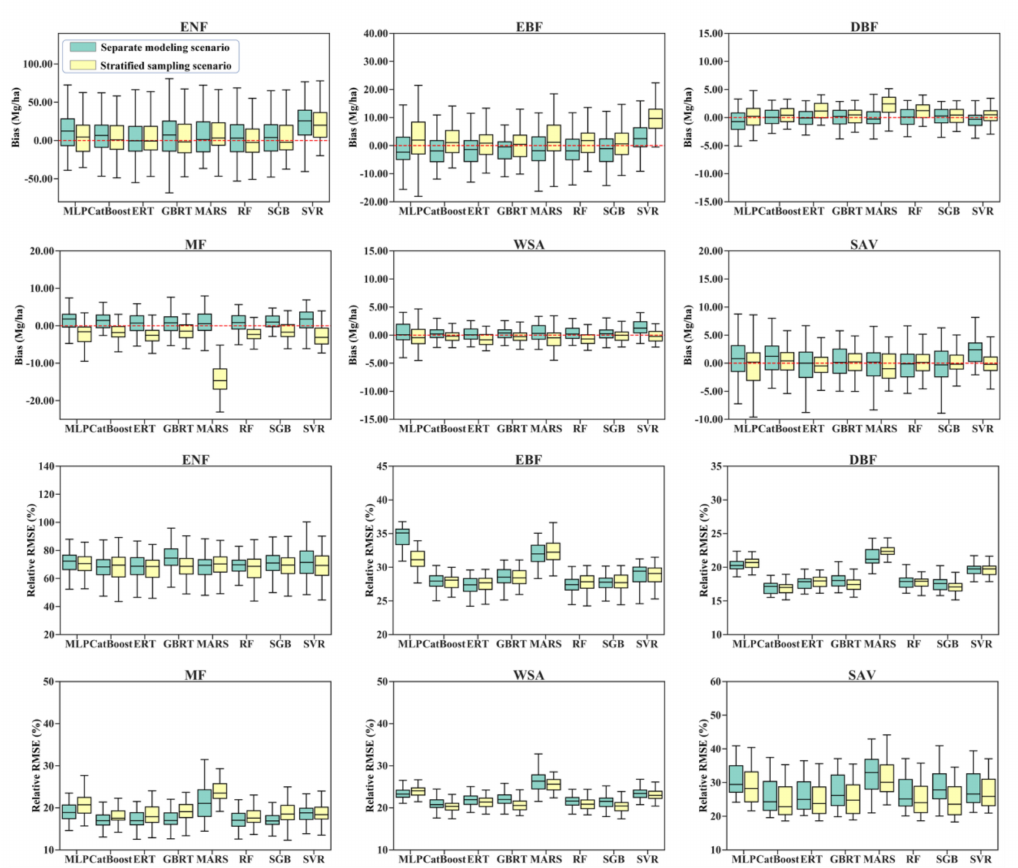
Figure 4. Distribution of 50 validated biases and relative RMSEs for eight AGB modeling algorithms under the stratified sampling scenario and separate modeling